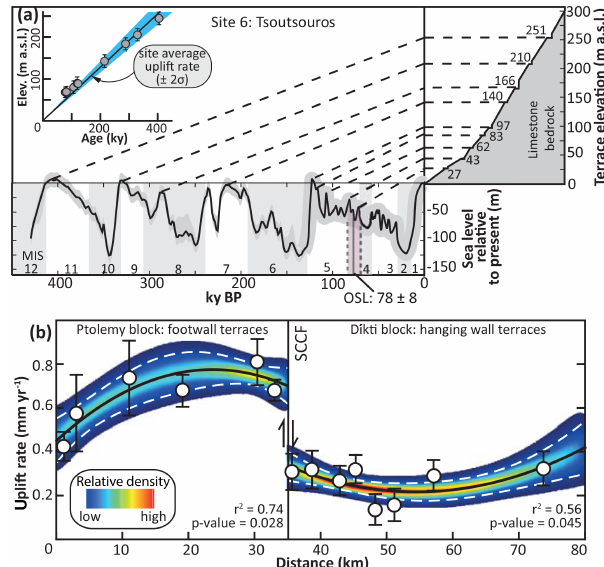
Figure 3. Correlation of the Tsoutsouros ( a – site 6; Fig. 1b) terrace sequences to the late Quaternary global sea level curve (after Gallen et al., 2014). The 0–125ky sea level curve was compiled from Lam- beck and Chappell (2001), while the 125–450ky segment is from Waelbroeck et al. (2002). Marine isotope stage (MIS) boundaries are from Lisiecki and Raymo (2005). Each terrace sequence is an- chored to the sea level curve with an optically simulated lumines- cence (OSL) burial age of fine sand collected from marine terrace deposits. The Tsoutsouros sequence shows the OSL age of the low- est terrace in the sequence from Gallen et al. (2014). Inset diagrams show the total uplift versus estimated terrace age ( ± 2 σ ) and site av- erage uplift rate from the Monte Carlo regression analysis (dashed back line) with 2 σ uncertainties (blue polygon). For this site the average uplift rate is 0.65 ± 0.08mmyr − 1 . (b) Post-fault-linkage site average uplift rates ( ± 2 σ ) are displayed as white circles. The coastal uplift model is shown as the black line and the dashed white lines depict the ± 2 σ uncertainties. The colored background shows the relative density of regression paths from the Monte Carlo anal- ysis. The location and sense of motion of the South-Central Crete fault (SCCF) is